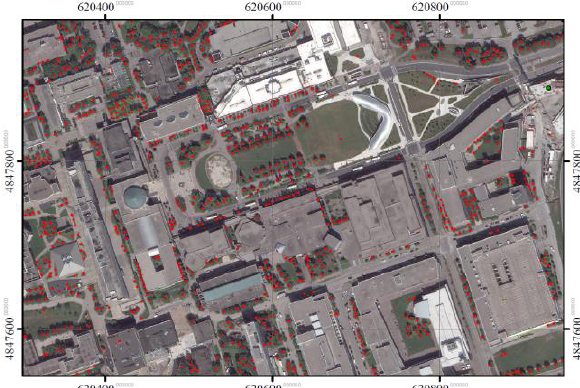
Figure 5: The detected trees for a subset with street trees using the combined worldview-3 imagery and airborne LiDAR data. The segments are overlaid on the true colour composite of workview-3 imagery.